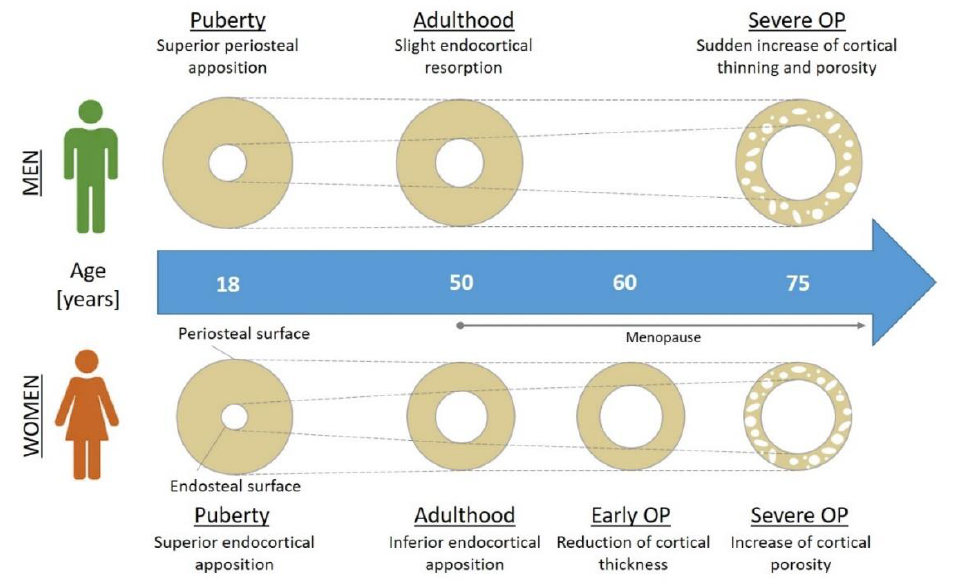
Figure 4. Osteoporosis (OP)-induced variations in cortical bone tissue. [18].